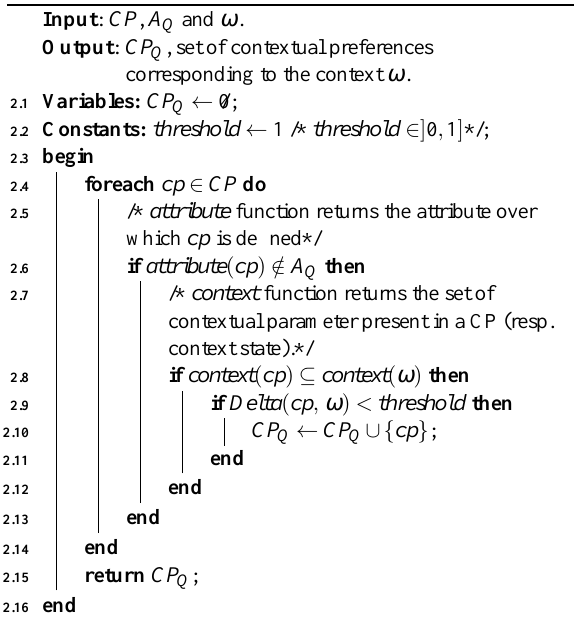
Algorithm 2: load cp